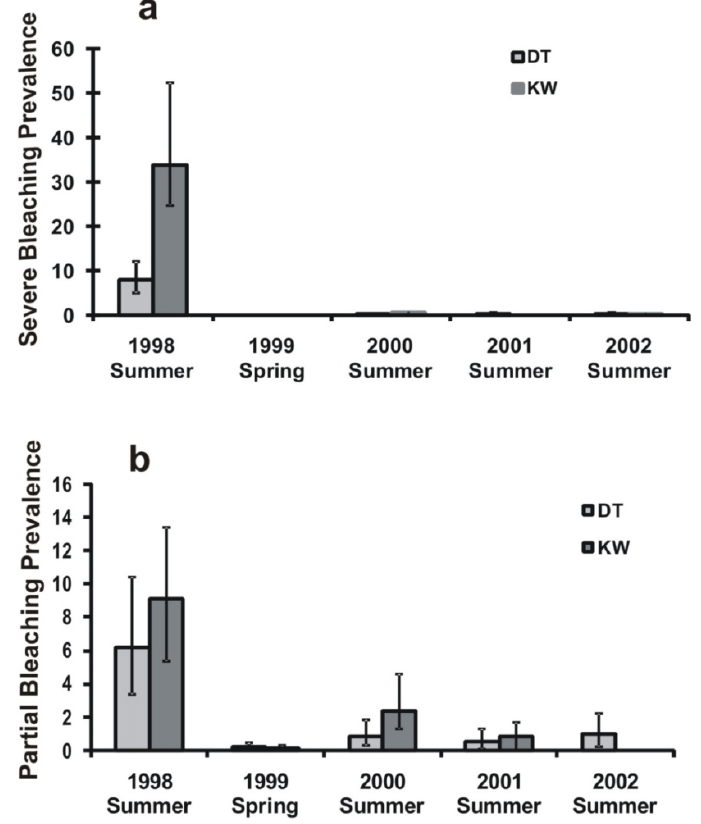
Figure 6 . Mean bleaching prevalence (percent of colonies affected) on Dry Tortugas